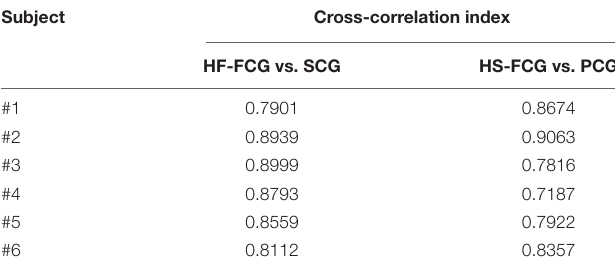
TABLE 3 | Cross-correlation indices of HF-FCG vs. SCG and HS-FCG vs. PCG.